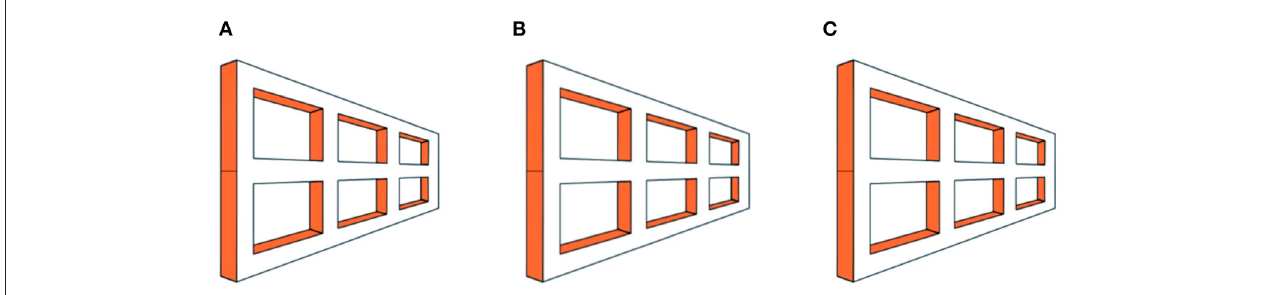
FIGURE 1 | The original Ames window illusion. The window appears to oscillate back and forth over a 180 ◦ range, although it actually rotates through 360 ◦ continuously. Panels (A) and (C) are identical, while panel (B) contains disparity. Please see Supplementary Video 1 for an